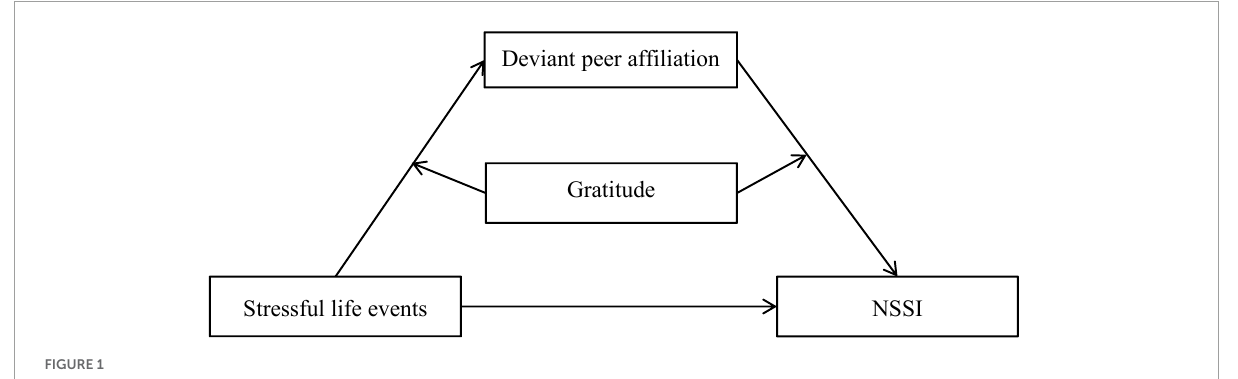
FIGURE1 The proposed mediated moderation model. NSSI, non-suicidal